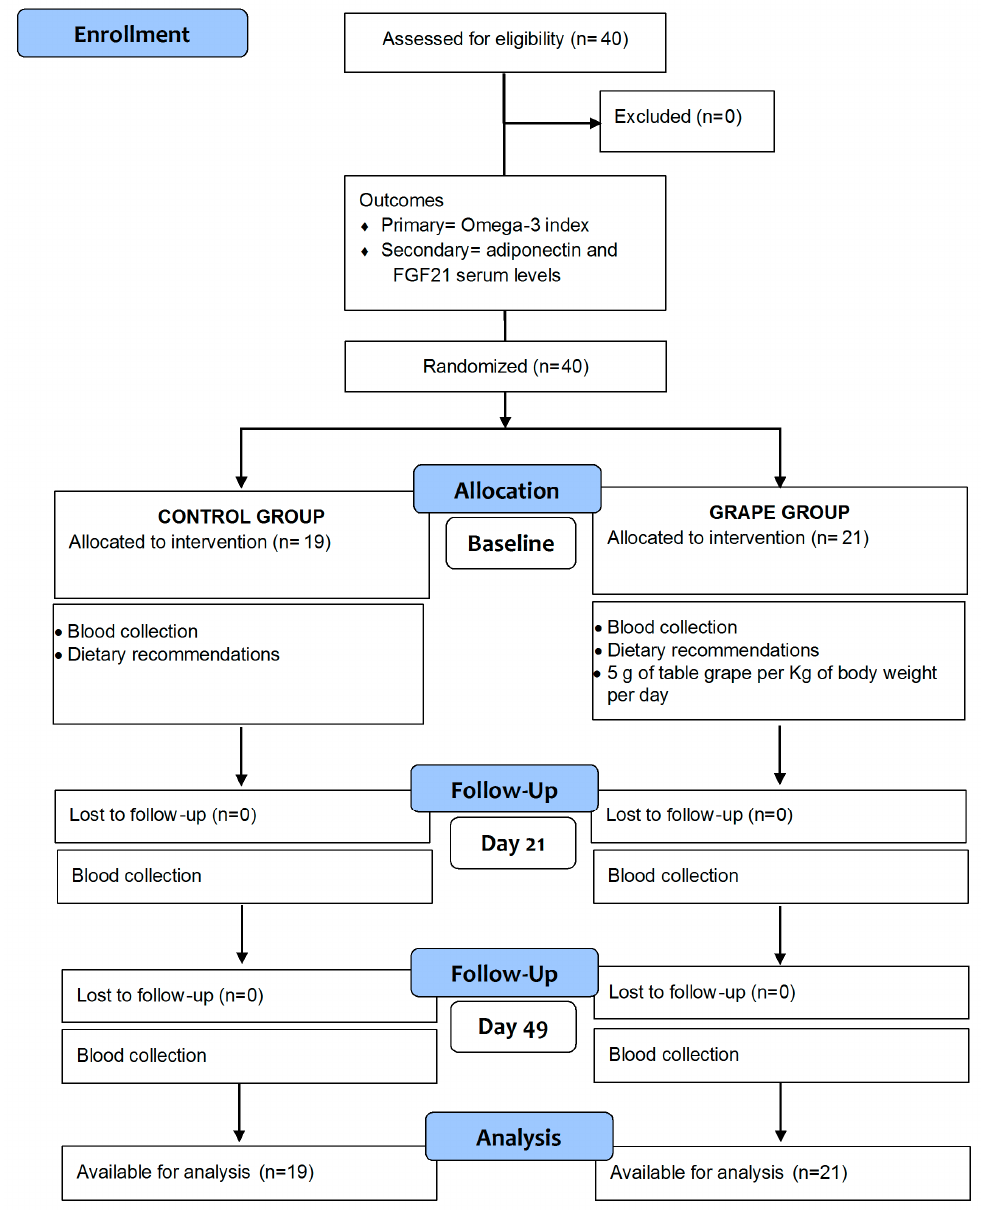
Figure 1. Flowchart of study design (Baseline, T0; Day 21, T1; Day 49, T2).